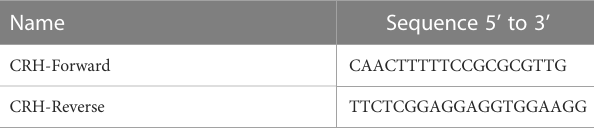
TABLE 1 Primer sequences used to amplify a fragment of feline CRH